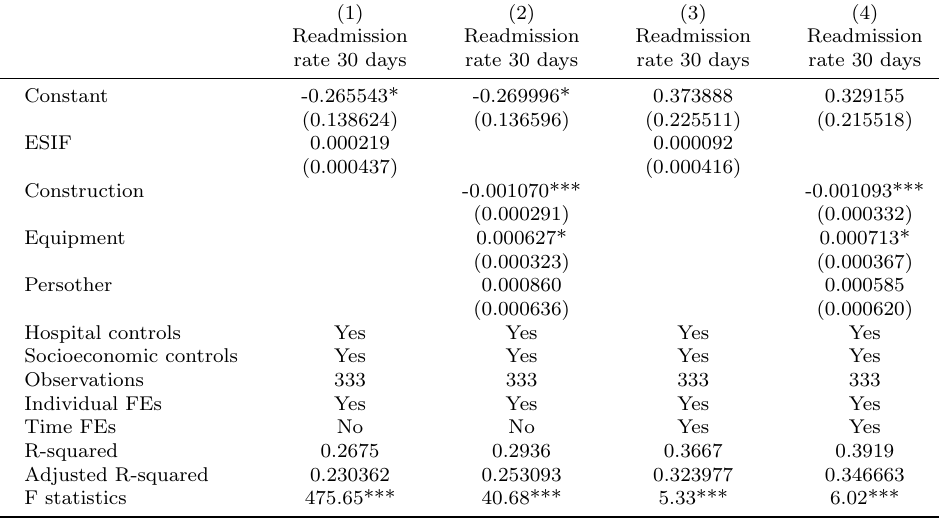
Table 3: Contemporaneous effect of cumulative ESIF on the readmission